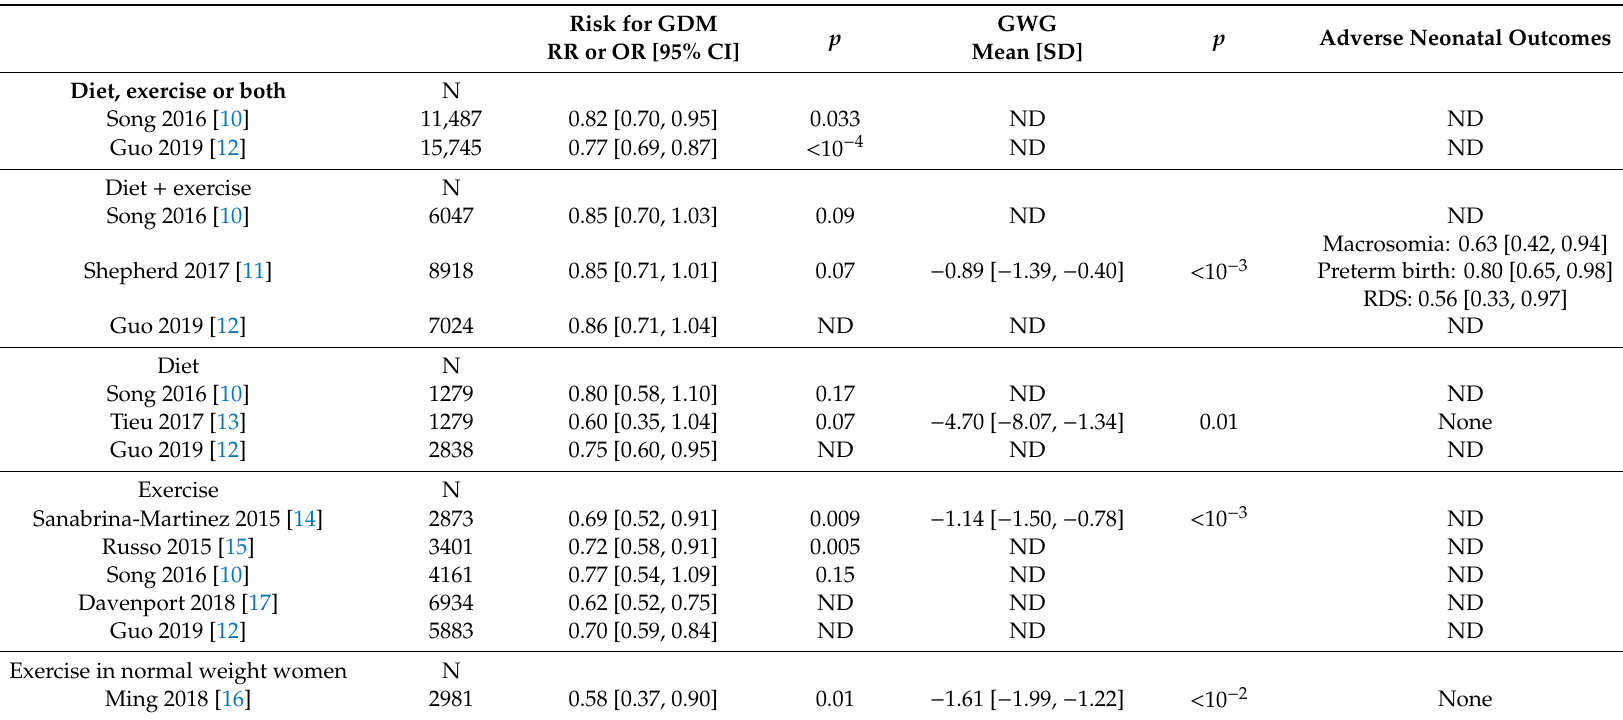
Table 1. E ff ect of lifestyle interventions during pregnancy on the risk of gestational diabetes (GDM), on gestational weight gain (GWG) and the risk of adverse neonatal outcomes according to meta-analyses. RDS: respiratory distress syndrome. ND: not determined.